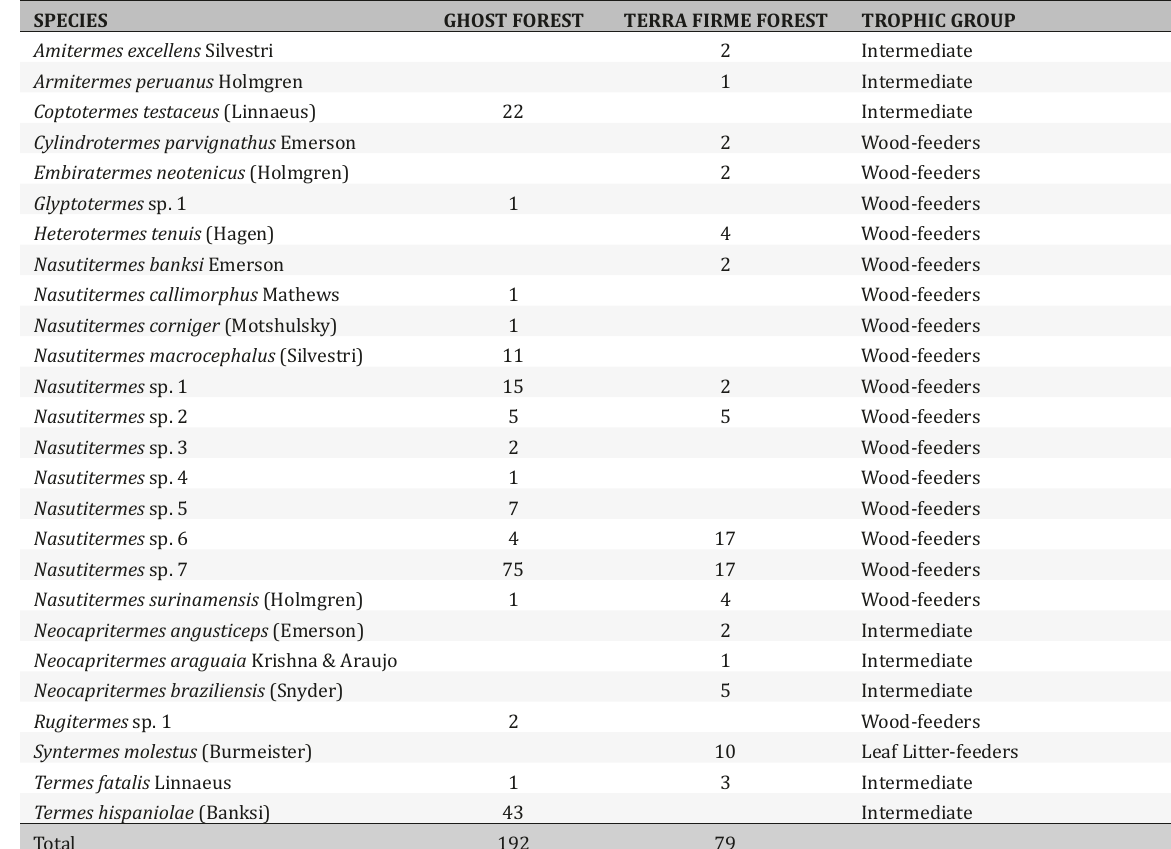
Termite species abundance and trophic group from the ghost forest and terra firme transects in the Balbina Hidroeletric Plant (UHB), Presidente Figueiredo, Brazil. Wood feeders: feed preferentially on dry wood; intermediate: feed on material between wood and humus or